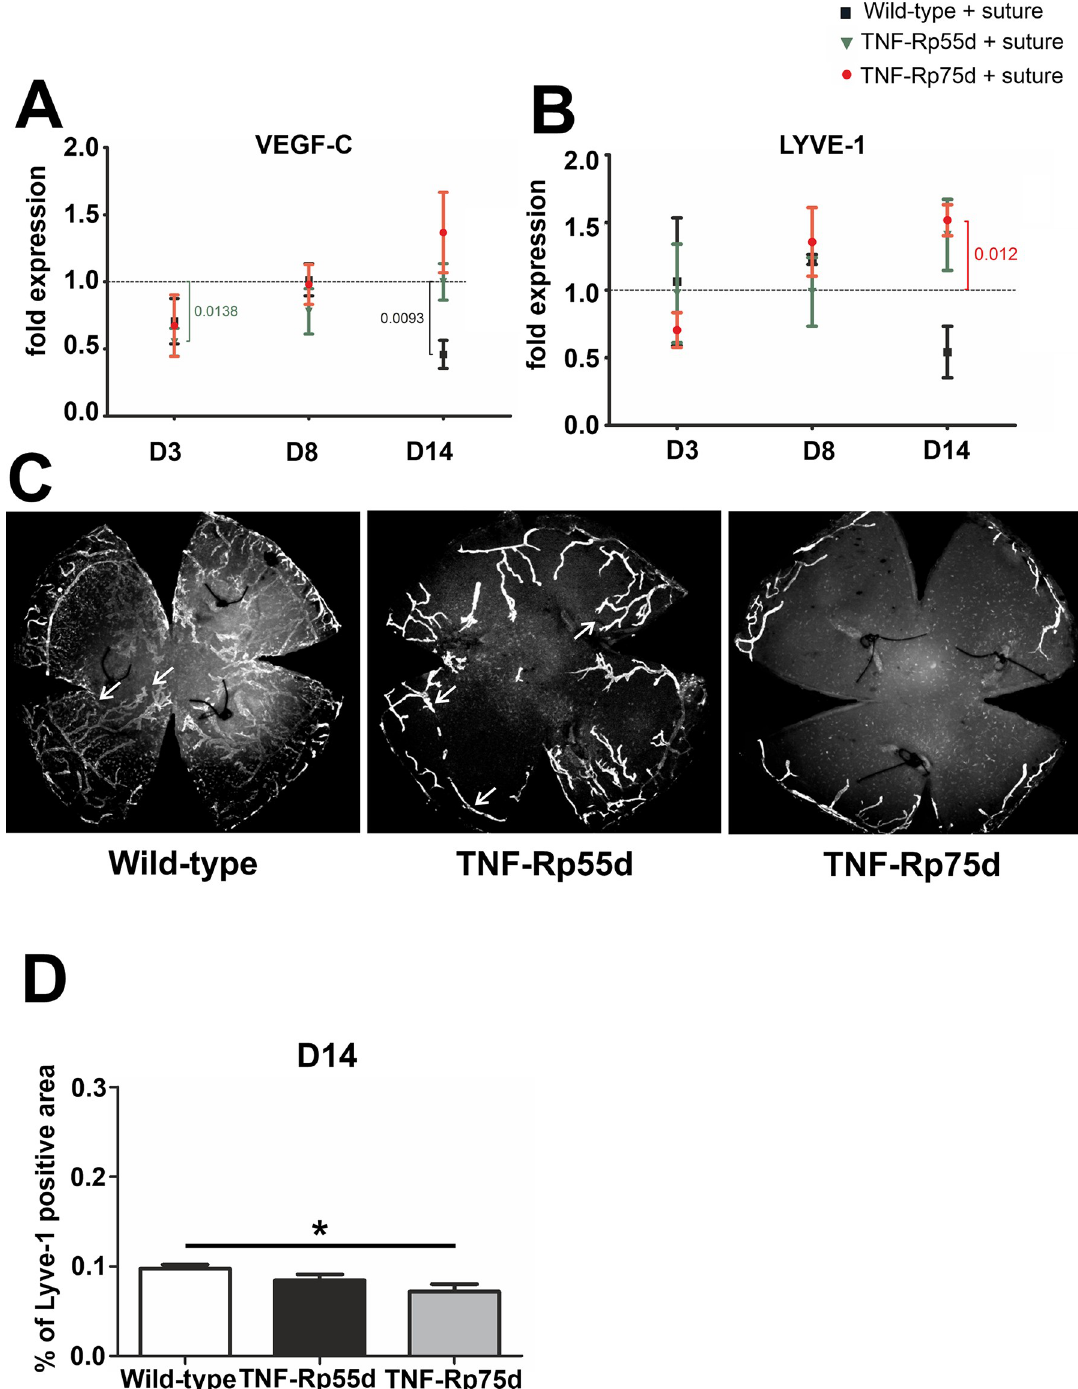
Fig 3. Corneal lymphangiogenesis in TNF-Rp55d mice and TNF-Rp75d mice in the suture model. A, B: Differential mRNA expression of VEGF-C (A) or LYVE-1 (B) in wild-type and TNF-Rp55d mice and TNF-Rp75d mice 3 days, 8 days, and 14 days after suture. Data are normalized to VEGF-A expression values of the respective genotype without suture (= 1); n = 2–3. C: Corneal flatmounts of wild-type and TNF-Rp55d mice and TNF-Rp75d mice 14 days after suture placement. Lymphatic vessels are visualized by Lyve-1-antibody. D: Quantification of percentage of LYVE-1 positive area compared to total corneal area in wild-type and TNF-Rp55d mice, and TNF-Rp75d mice 14 days after suture placement. n = 7–8.